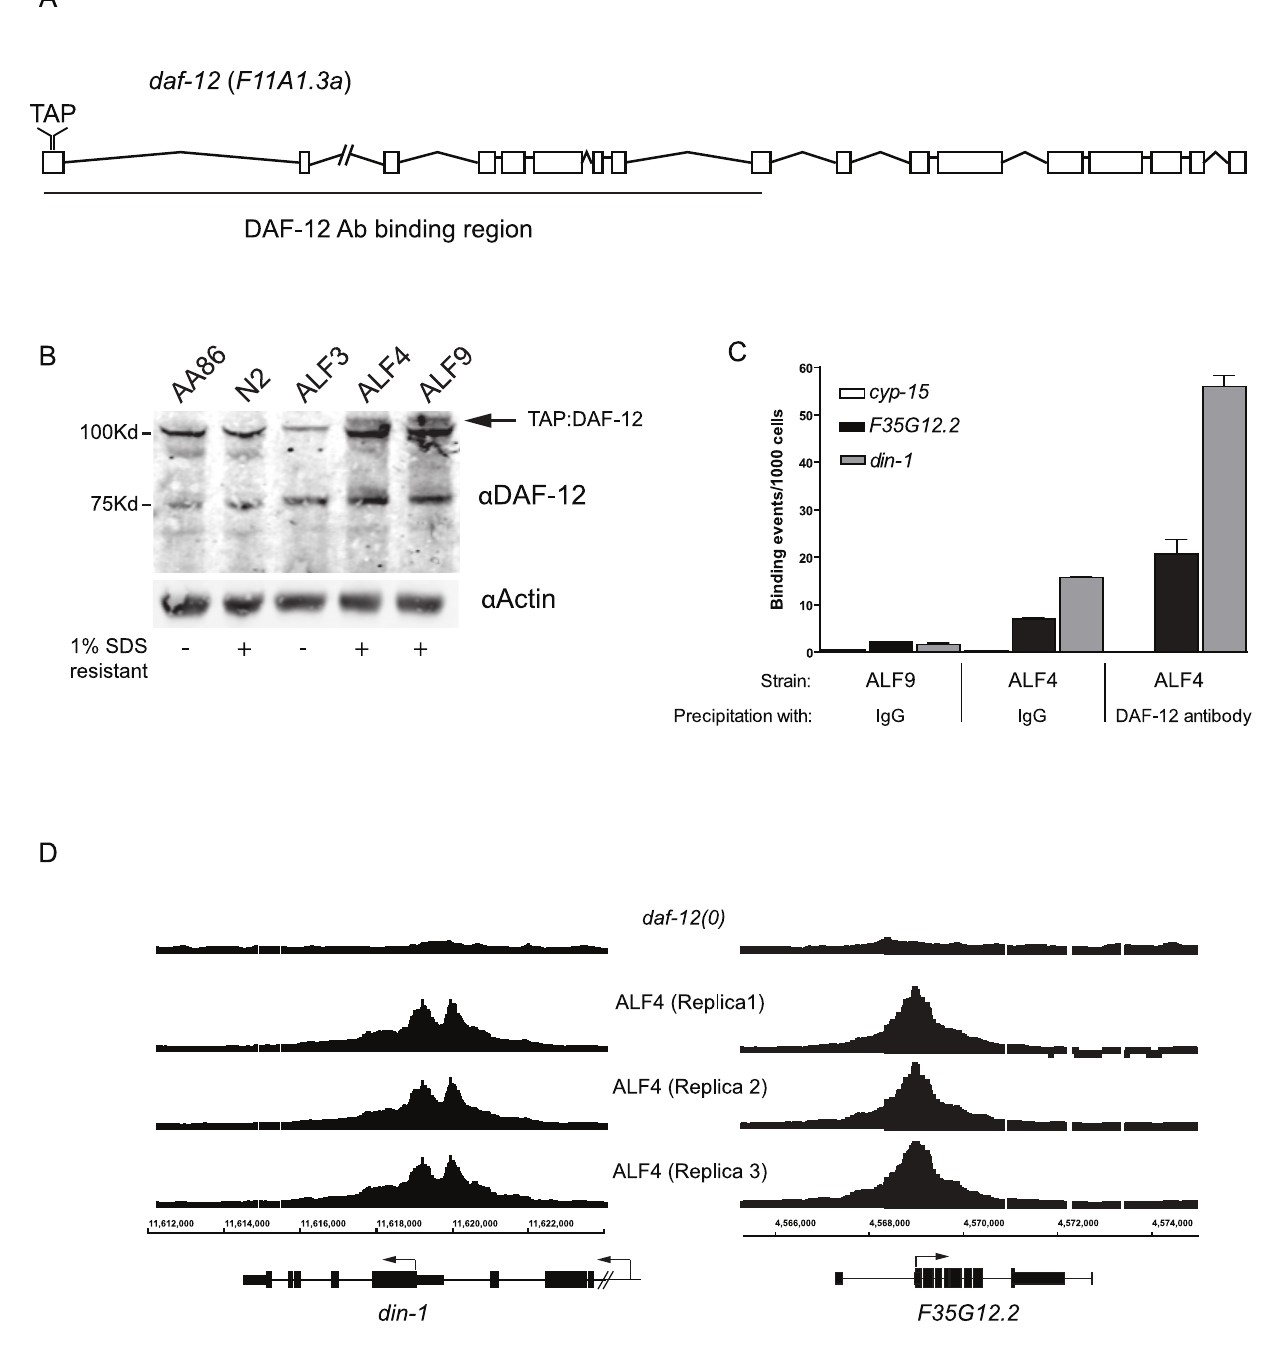
Figure 1. Generation of DAF-12 transgenic worms. ( A ) Schematic of daf-12 transcript showing the TAP-tag and region recognized by the anti- DAF-12 antibody in the ligand binding domain (LBD). ( B ) Expression of the transgene in ALF4 and ALF9 lines was confirmed by Western blot using an anti-DAF-12 antibody. Actin was used as a loading control. The function of the TAP-tagged daf-12 transgene was confirmed by incubation of starved worms with 1% SDS. ( C ) TAP-tagged DAF-12 bound chromatin was precipitated from ALF9 and ALF4 with an anti-DAF-12 antibody or IgG sepharose. Regions of interest were quantified by qPCR. ( D ) Binding sites within din-1 and F35G12.2 were visualized in tiling arrays using DNA from three replicas (ALF4) and control ( daf-12(0) ) with the Integrated Genome Browser software (Affymetrix). Arrows indicate initiation codons.